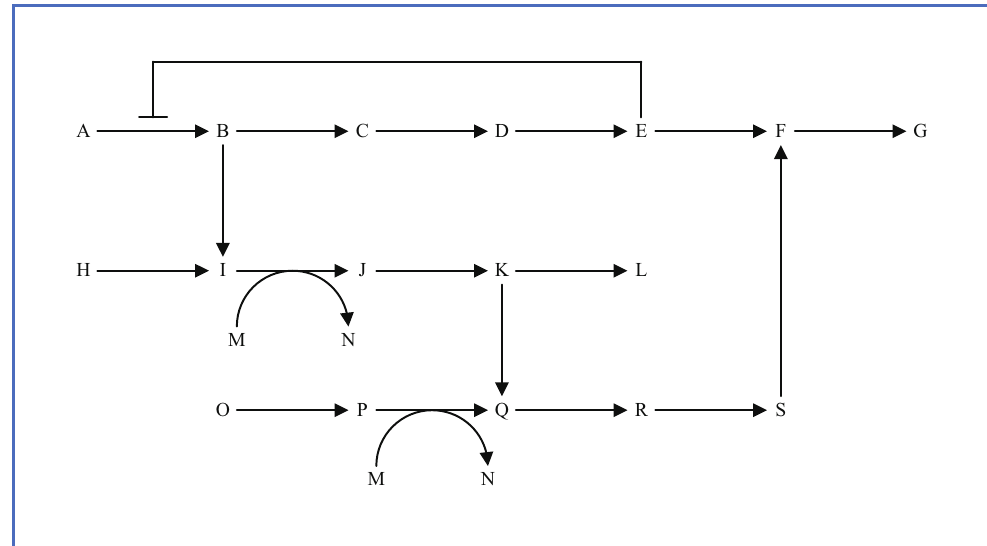
Figure 3. Example metabolic